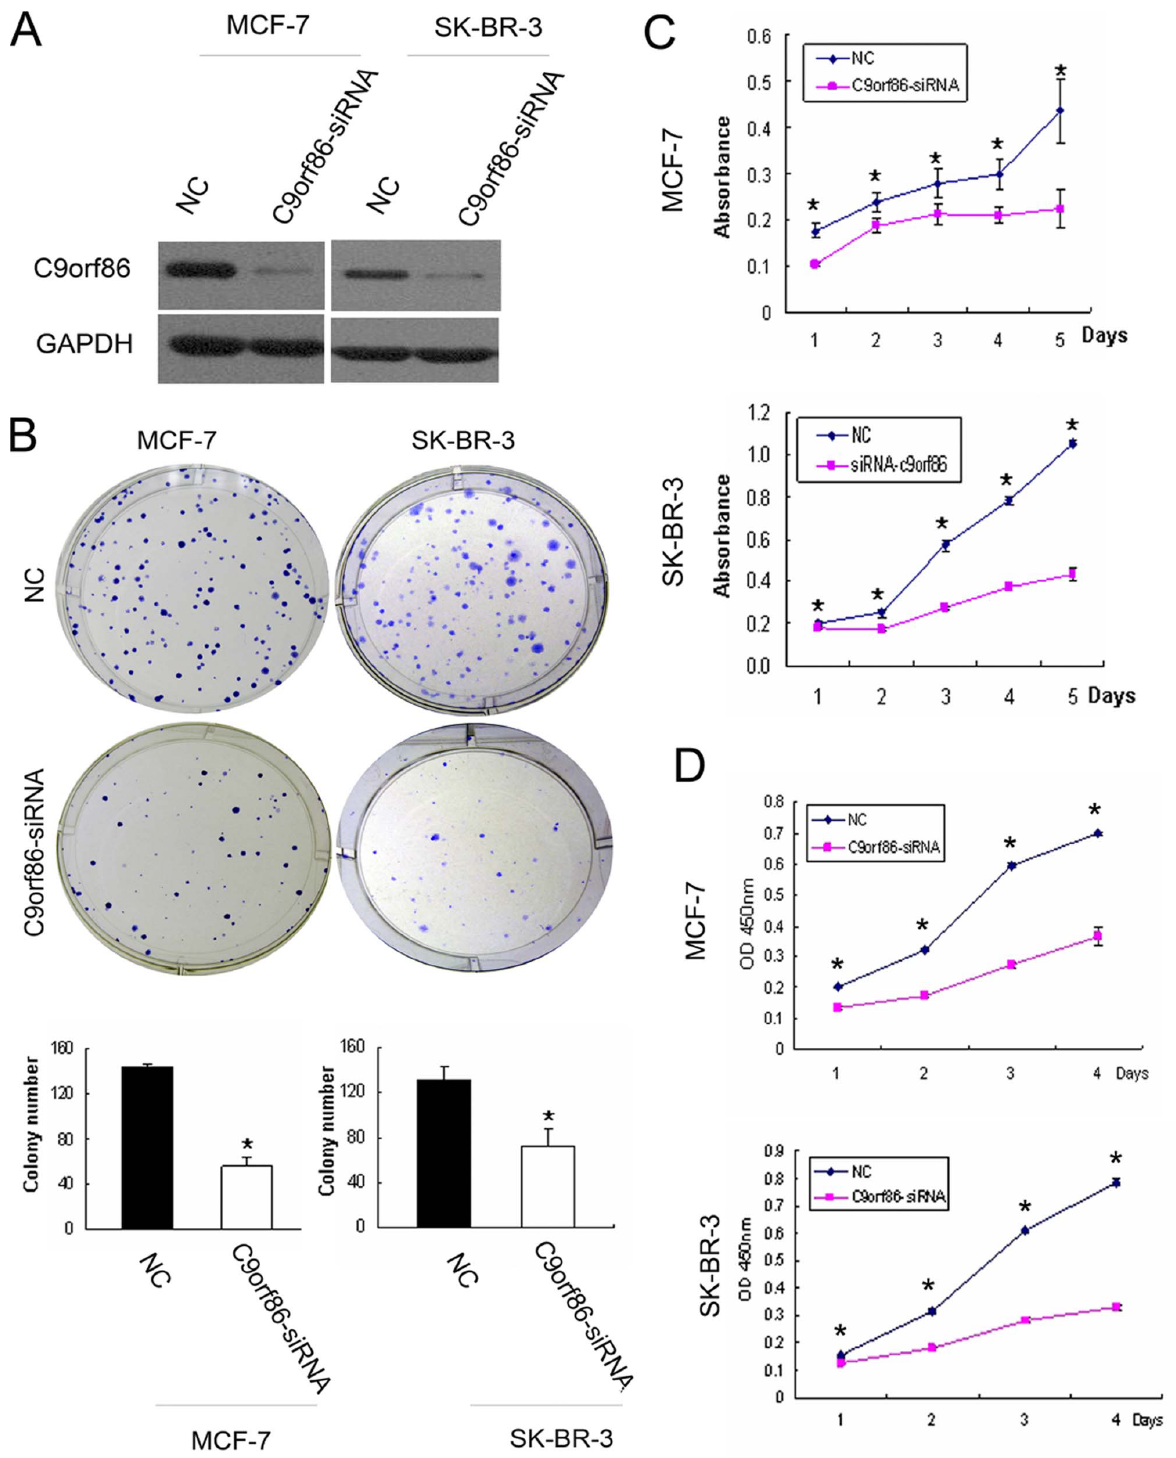
Figure 3. Effect of C9orf86 knockdown on MCF-7 and SK-BR-3 cell growth in nude mice. (A) Photographs of nude mice and tumors extracted from C9orf86 knockdown and NC groups (MCF-7 and SK-BR-3). (B) Tumors were weighed after animals were killed 7 weeks post-tumor cell injection. There was a decreasing trend in both the number of cells and size of tumors in the C9orf86 knockdown and NC group of mice for MCF-7 (P , 0.01) and SK-BR-3 (P=0.261) cells. (C) Growth curves for tumors in MCF-7-C9orf86-siRNA-treated group (n=6) versus the MCF-7-NC-treated group (n=8) (all P values , 0.01) and growth curves for tumors in SK-BR-3-C9orf86-siRNA-treated group (n=2) versus SK-BR-3-NC-treated group (n=7) (all P values . 0.05). (D) The level of C9orf86 mRNA from the tumor 7 weeks after the injection in NC-group was higher than C9orf86-siRNA group (MCF-7 and SK-BR-3, all P values , 0.05). Data are shown as the mean 6 SD. *P , 0.05. NC, negative control.